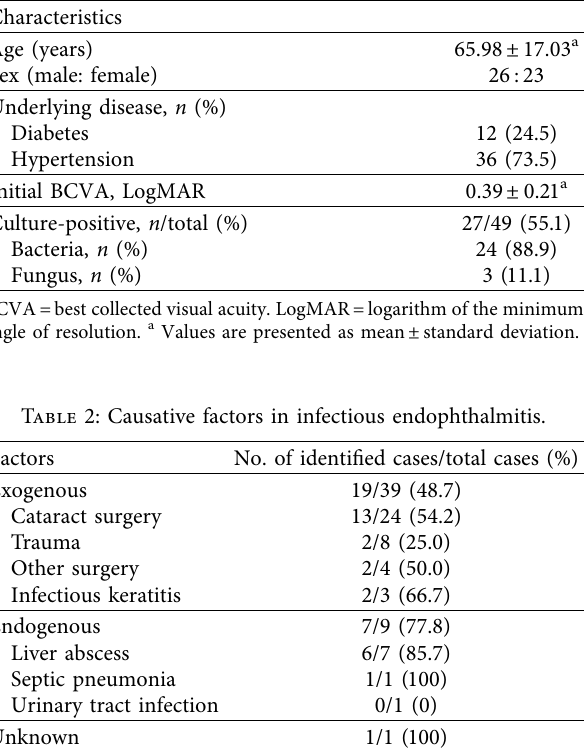
Table 1: Baseline characteristics of patients in this study.